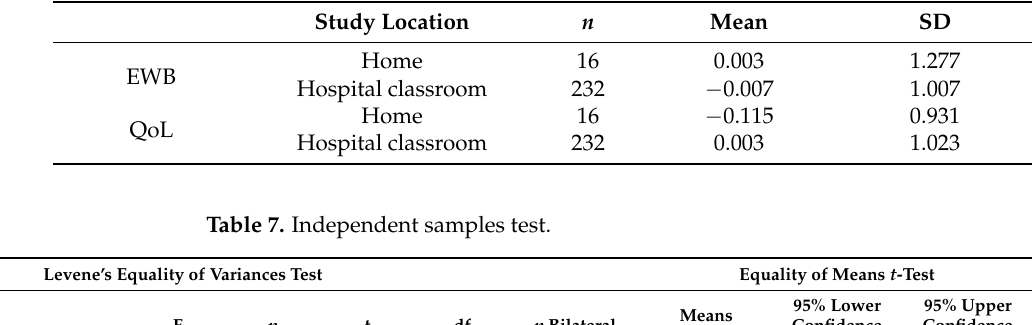
Table 6. Difference of means according to study location (home vs. hospital classroom).